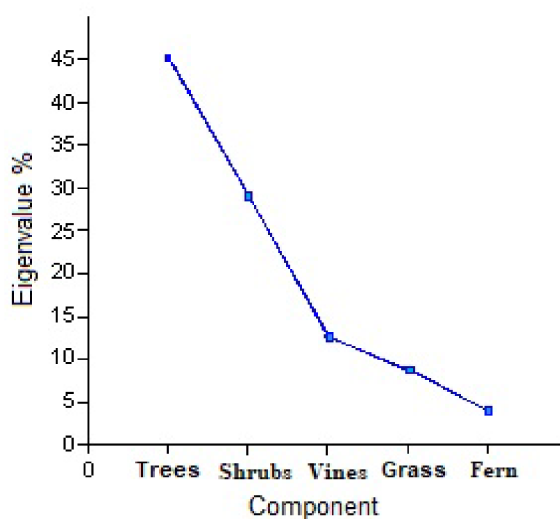
Figure 1. Principal component analysis showing the relationship between leafhoppers and plant